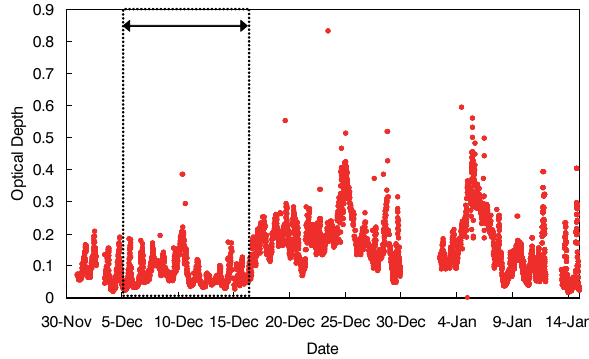
Fig. 2. Time series of optical depth over Atacama from 1 Decem- ber 2009 to 17 January 2010. The arrow indicates the period chosen for data analysis in this study, from 5 to 16 December